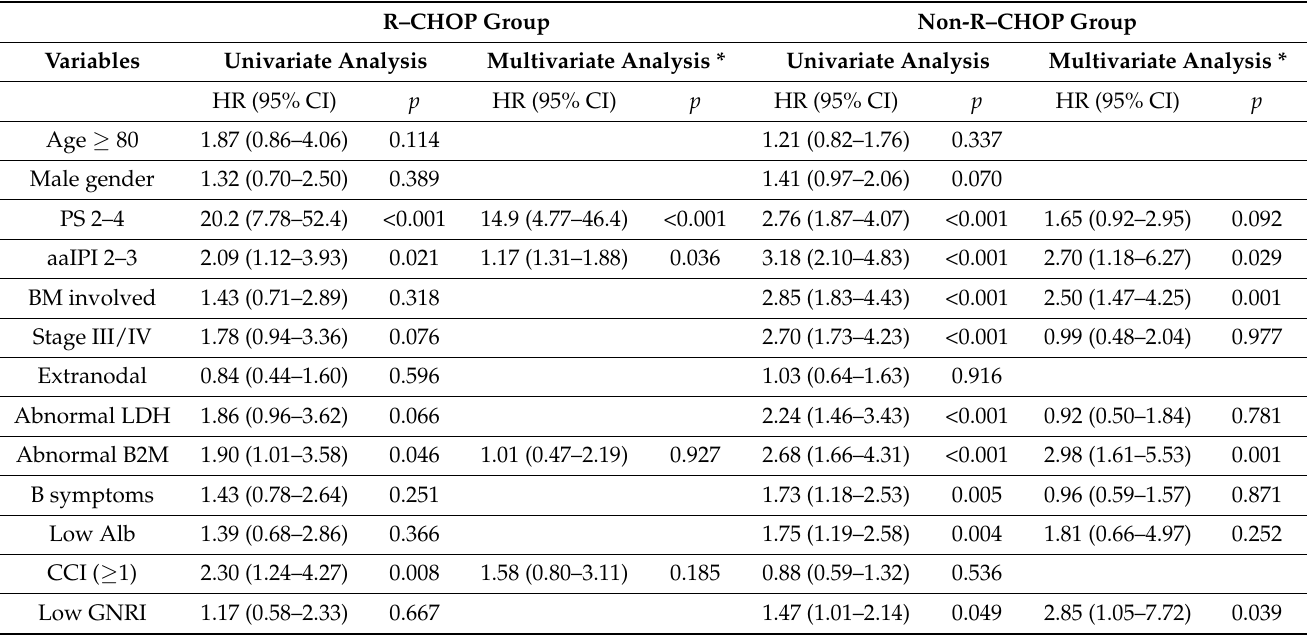
Figure 3. PFS and OS of the non-R–CHOP group stratified by the aaIPI ( A , B ), GNRI ( C , D ), and CCI ( E , F ). Table 5. The prognostic factors for PFS according to univariate and multivariate Cox